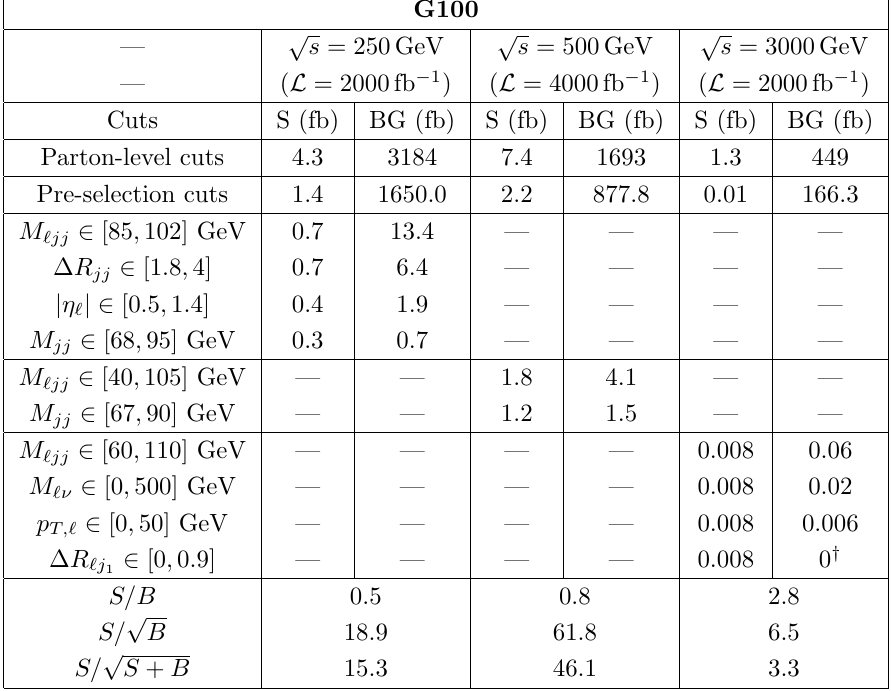
Table 7 . Cut (cid:13)ow table for generalized CW model G100